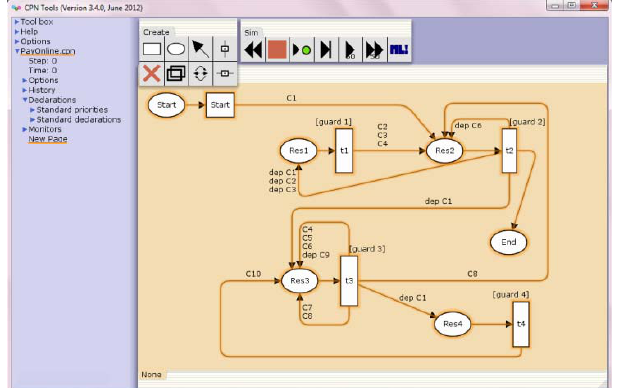
Fig. 11. The colored Petri net of the online shopping system after the execution